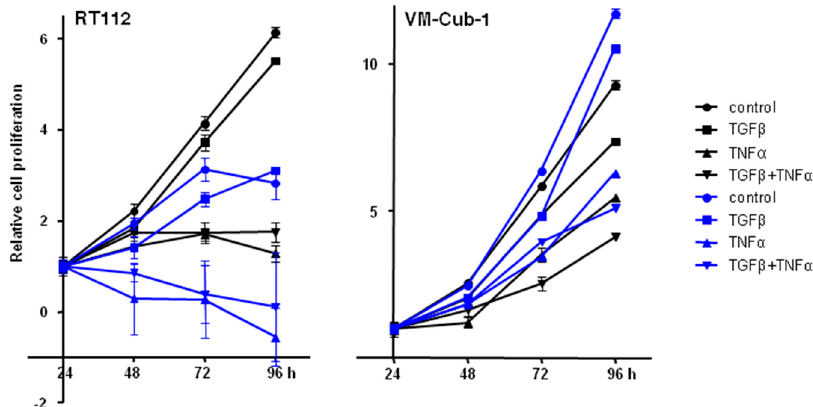
Figure 10. E ff ect of TGF β , TNF α , or concomitant TGF β + TNF α treatments on vector-only and HDAC5 expressing UCCs. Cells were treated with TGF β , TNF α , or both, or left untreated. Cell proliferation was followed by MTT assays at 24, 48, 72, and 96 h. The 24 h data of each cell line was set as “1”. Values represent means ± SD (error bars) of quadruplicates. left: RT112, right: VM-Cub-1 cells. Black lines and symbols: vector-only cells; Blue lines and symbols: HDAC5 transduced cells. All cytokine treatments caused significant ( t -test, p < 0.05) decreases compared to the respective untreated controls, except for the TGF β treatment of RT112 at 96 h.